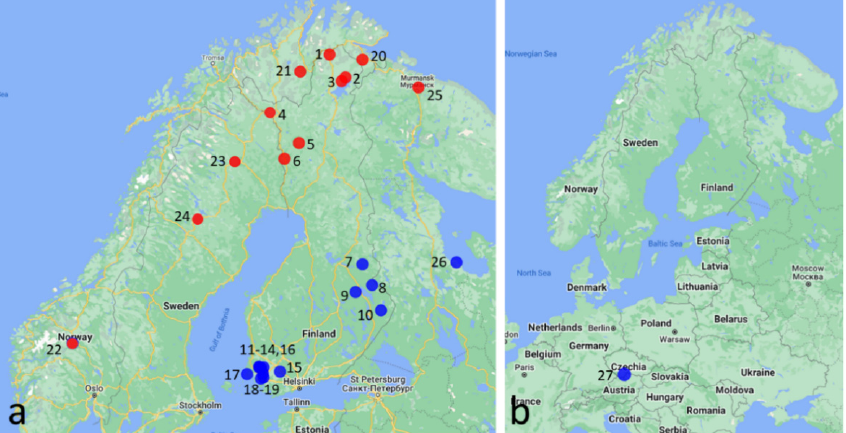
Figure 1. Sampling sites of C. ledi in ( a ) Fennoscandia and ( b ) Czech Republic. Numbers correspond to the numbers of locations presented in Table 1. Red dots: genuine parthenogenetic populations and bisexual populations carrying haplotype H1. Blue dots: populations where diploid females and males carrying haplotype H2 reproduce bisexually. Table 1. Sampling locations, number of specimens, male frequency, and collection date of Cacopsylla ledi analyzed in the present study.